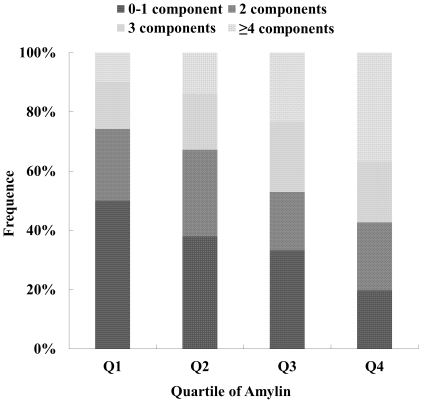
The severity of MetS according to amylin quartiles.
P<0.001 for trend.